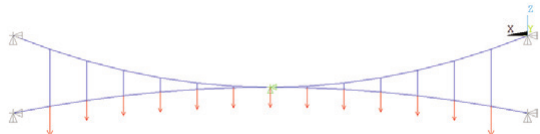
Fig. 11. 2D numerical model of the structure, where plywood boards are placed with the clearances and the deck behaves in bending in transversal direction